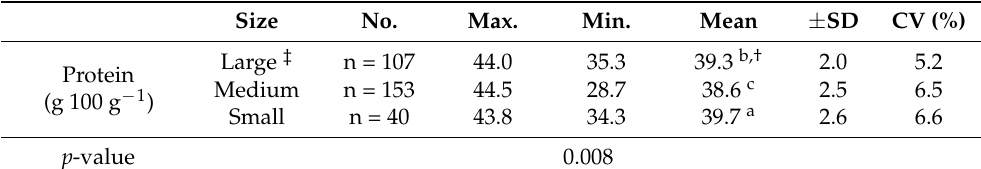
Table 3. Maximum, minimum and mean value of protein contents according to seed sizes in 300 soybean germplasms. Size No. Max. Min.